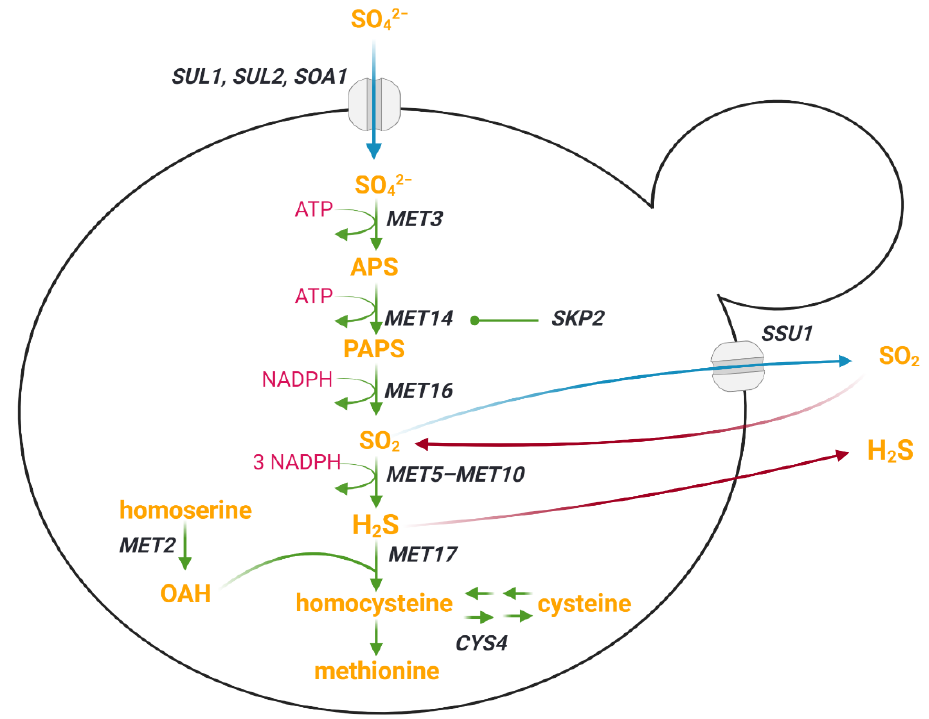
Figure 1. Sulfur assimilation pathway (SAP) in Saccharomyces cerevisiae . Blue arrows: transporter mediated flux. Red arrows: diffusion. Green arrows: enzymatic reactions. Dot line: protein regulator. Text in orange: compounds. Text in pink: cellular energetic cost. Text in black: genes.